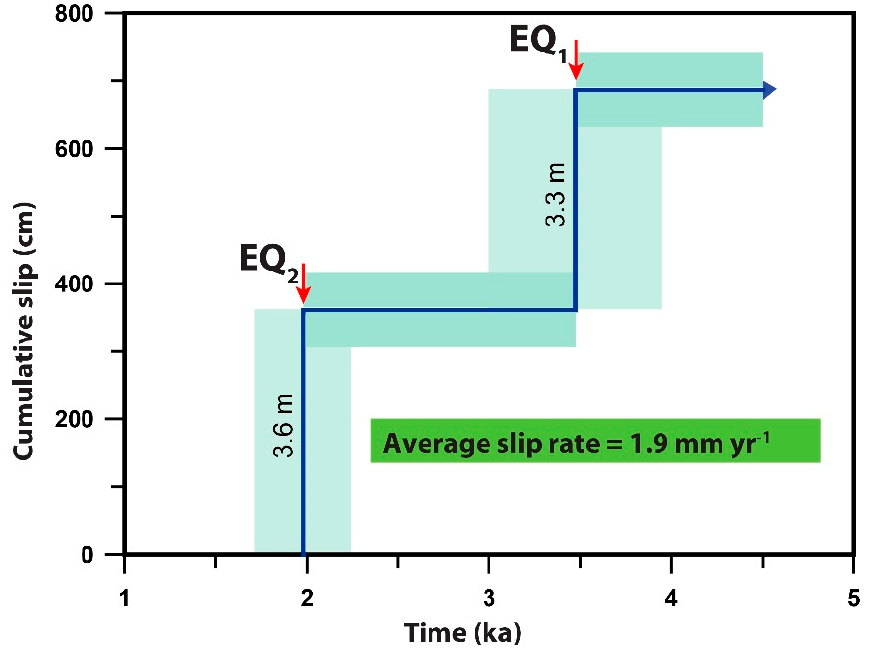
Figure 8. Cumulative slip versus time. Green bands indicate the uncertainties of seismic events ages and colluvium level obtained from modeling of Manast ı r fault; the average slip rate is 1.9 mm yr − 1 .